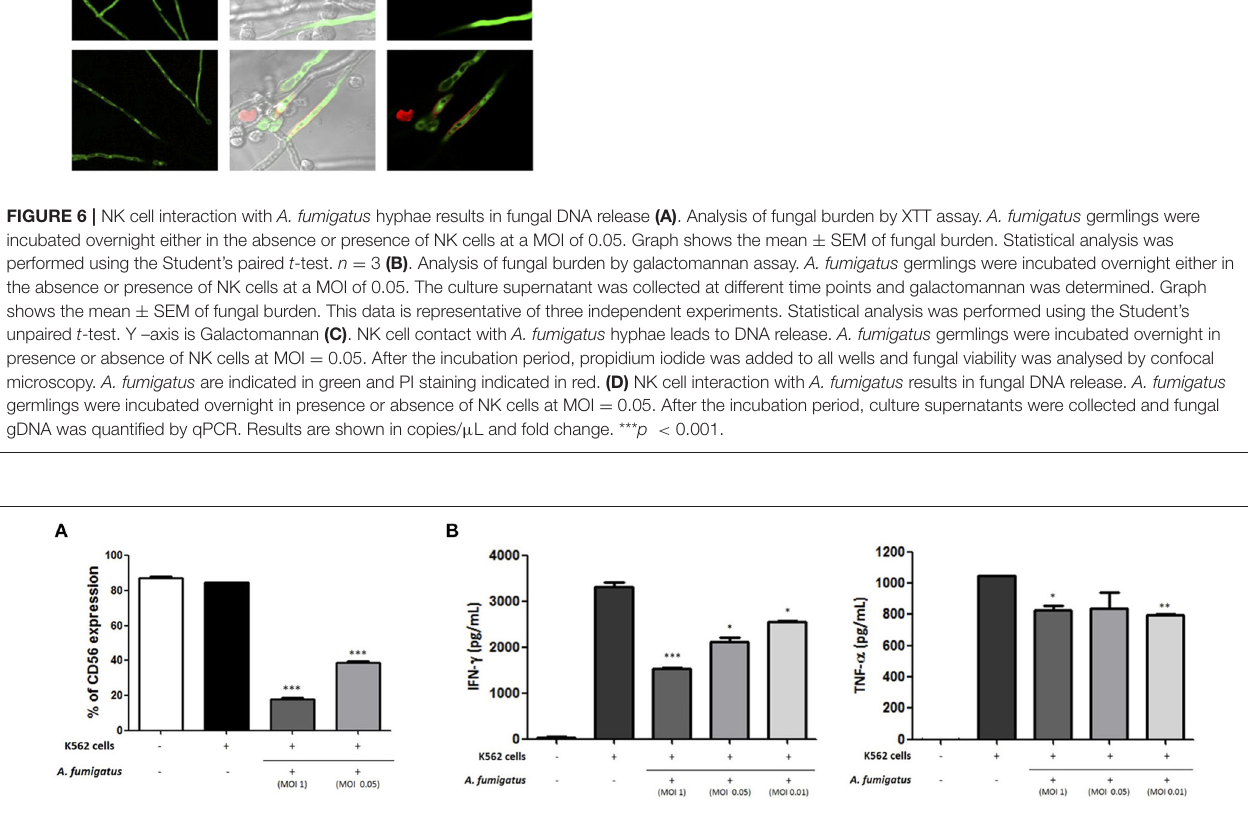
Frontiers in Immunology |